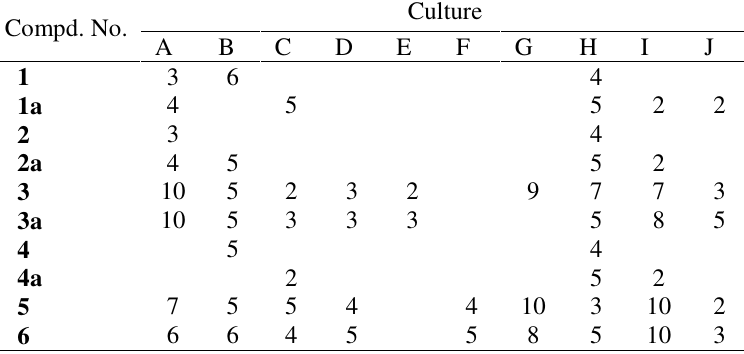
Table 1. Antimicrobial activity of 3-aryl-5-styrylisoxazoline and 3,5-diarylisoxazoline